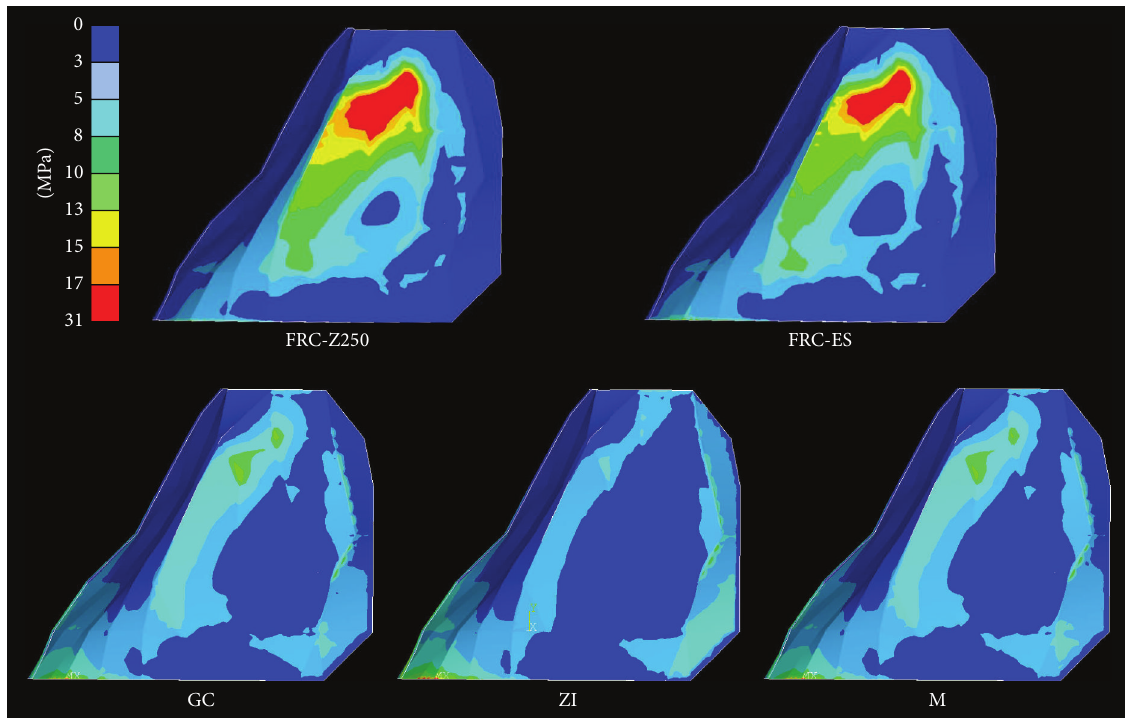
Figure 6: Principal stress distribution within the cement layer for two-unit cantilever RBFDPs of various framework